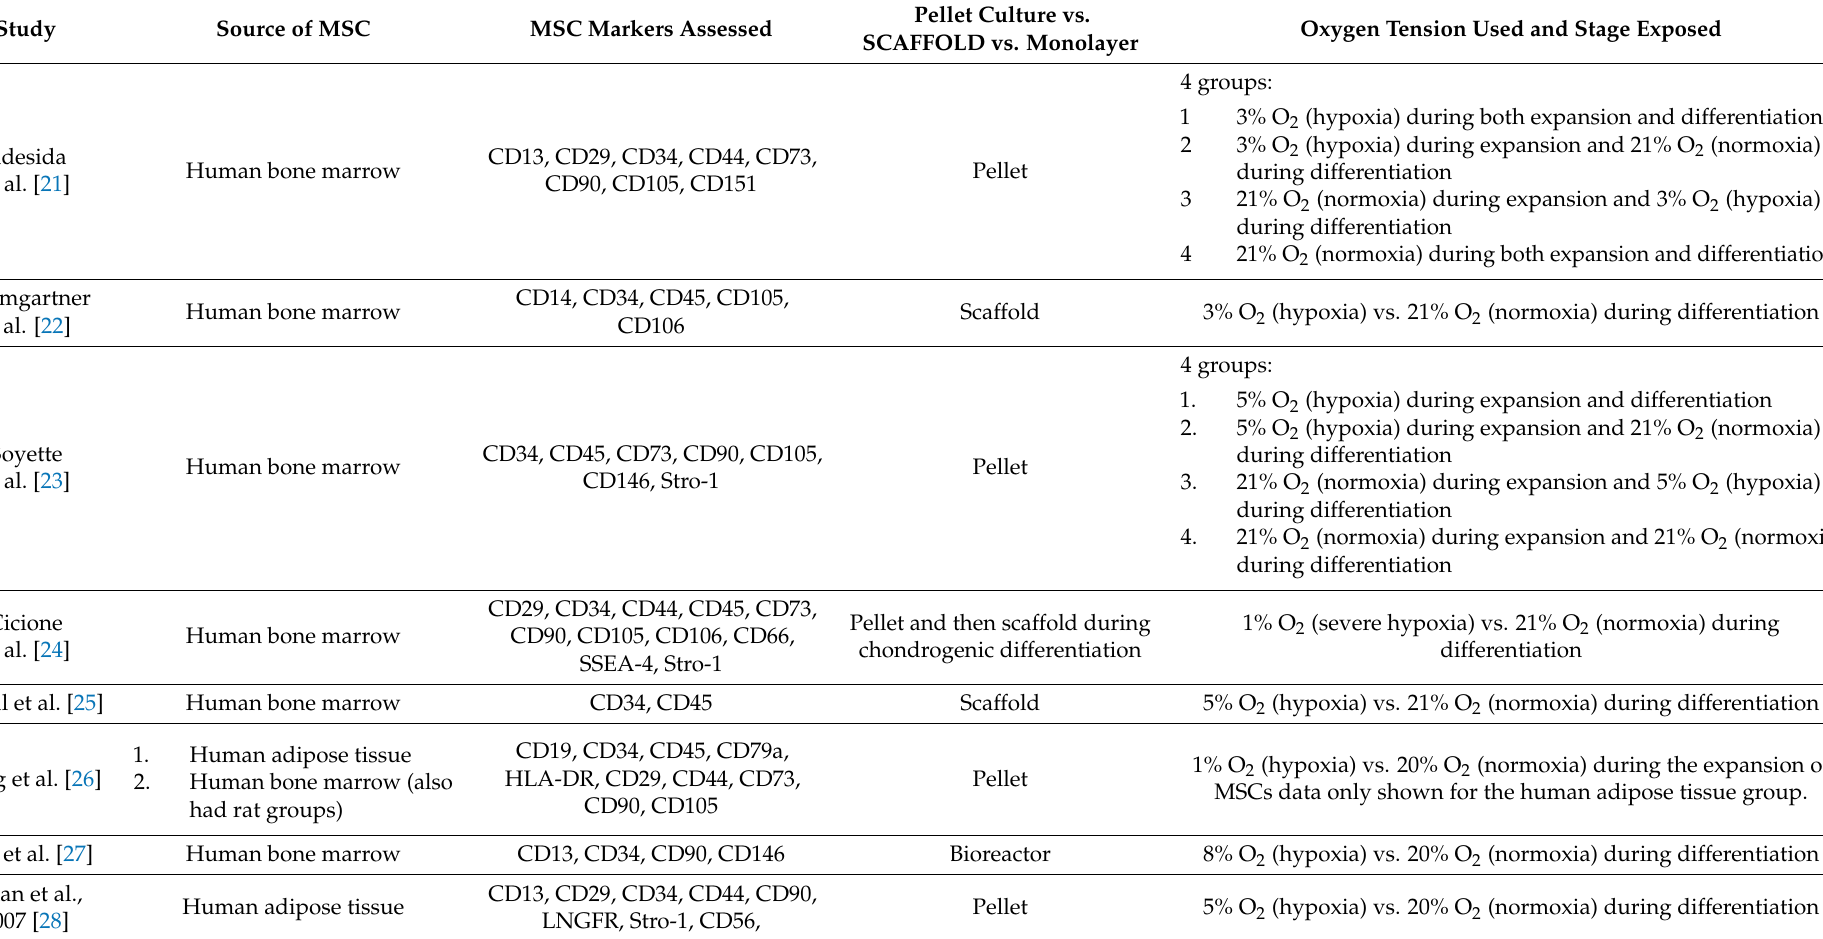
Table 1. Study Characteristics. Shows the following information for each study included in this review: source of MCSs, MSC markers assessed for, pellet or